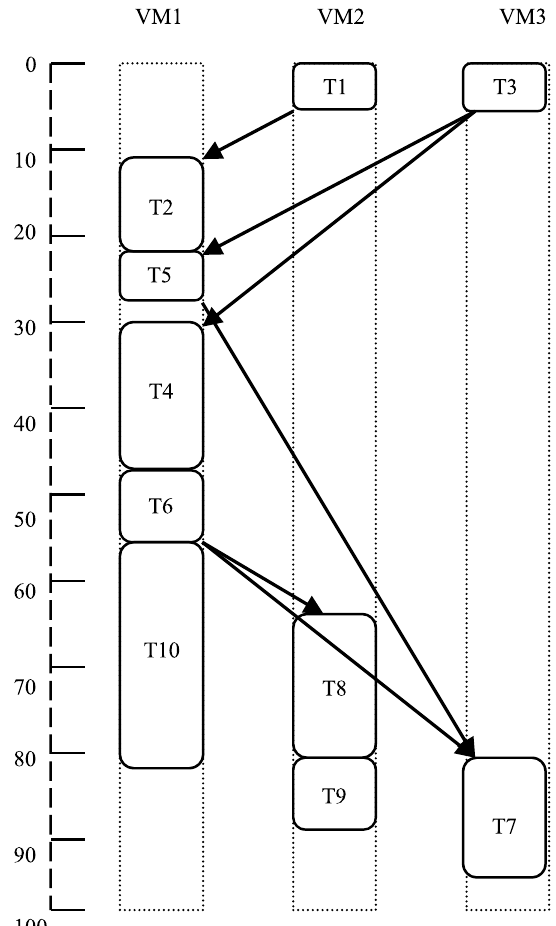
Fig.5 Scheduling of DAG with modified HEFT Algorithm. (Use Of maximum Computation Cost in Rank Calculation & Schedule length is